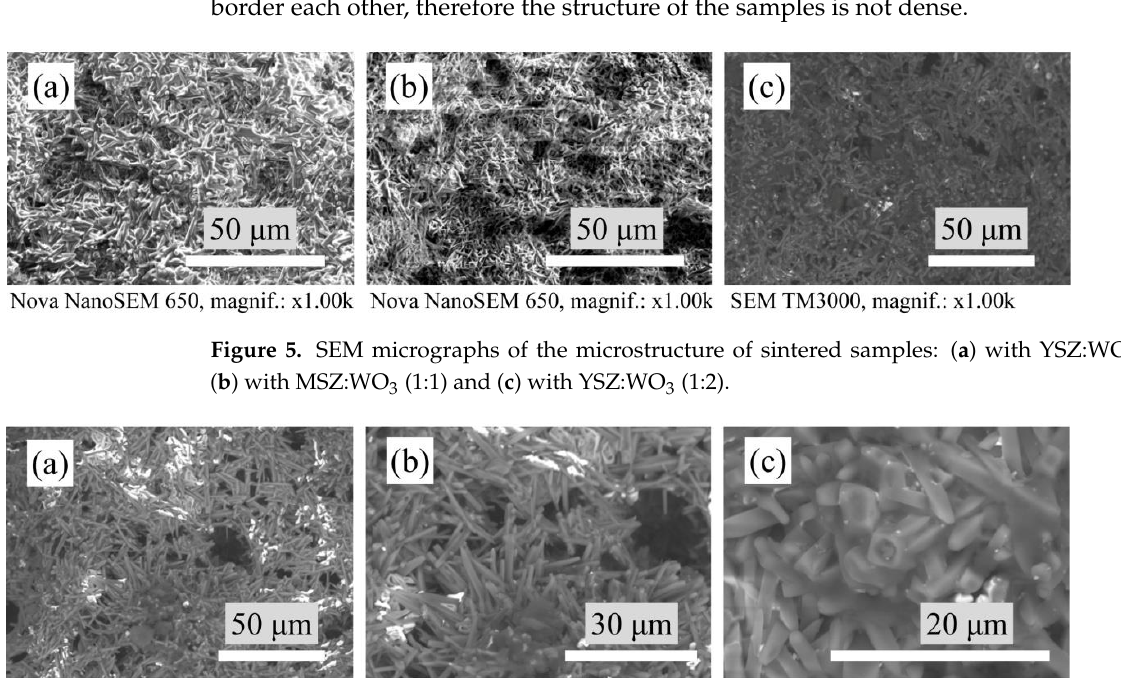
Figure 6. SEM micrographs of the microstructure of sintered samples with MSZ:WO 3 (1:2): ( a ) magnification ×1.00k, ( b ) magnification ×2.00k and ( c ) magnification ×5.00k.